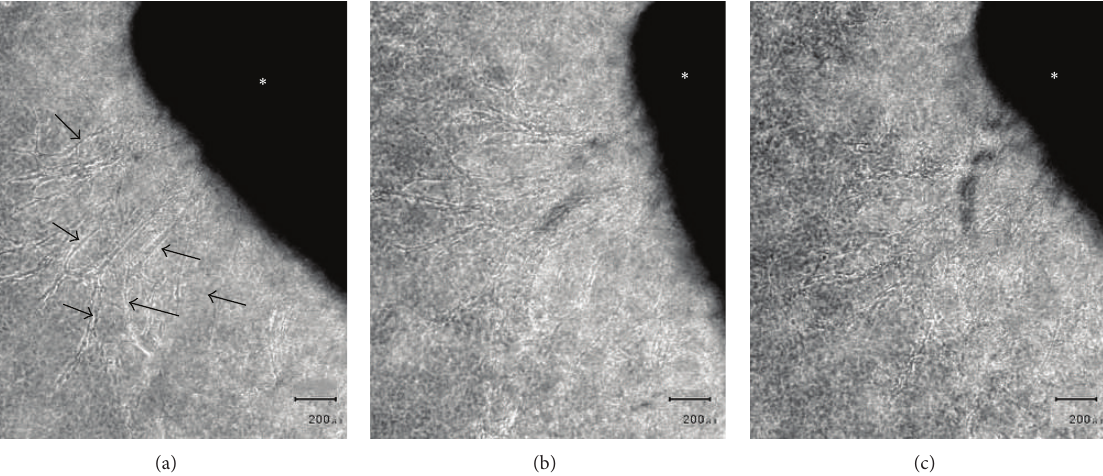
Figure 9: Effect of lovastatin (mevinolin) after tube formation. (a)–(c) After tube formation, lovastatin treatment induced the degradation of newly formed capillary tubes (arrows). (a) Before Lovastatin treatment; (b) after 24 hours; (c) after 48 hours; rat aortic explant ( ∗ ). Scale bar = 200 𝜇